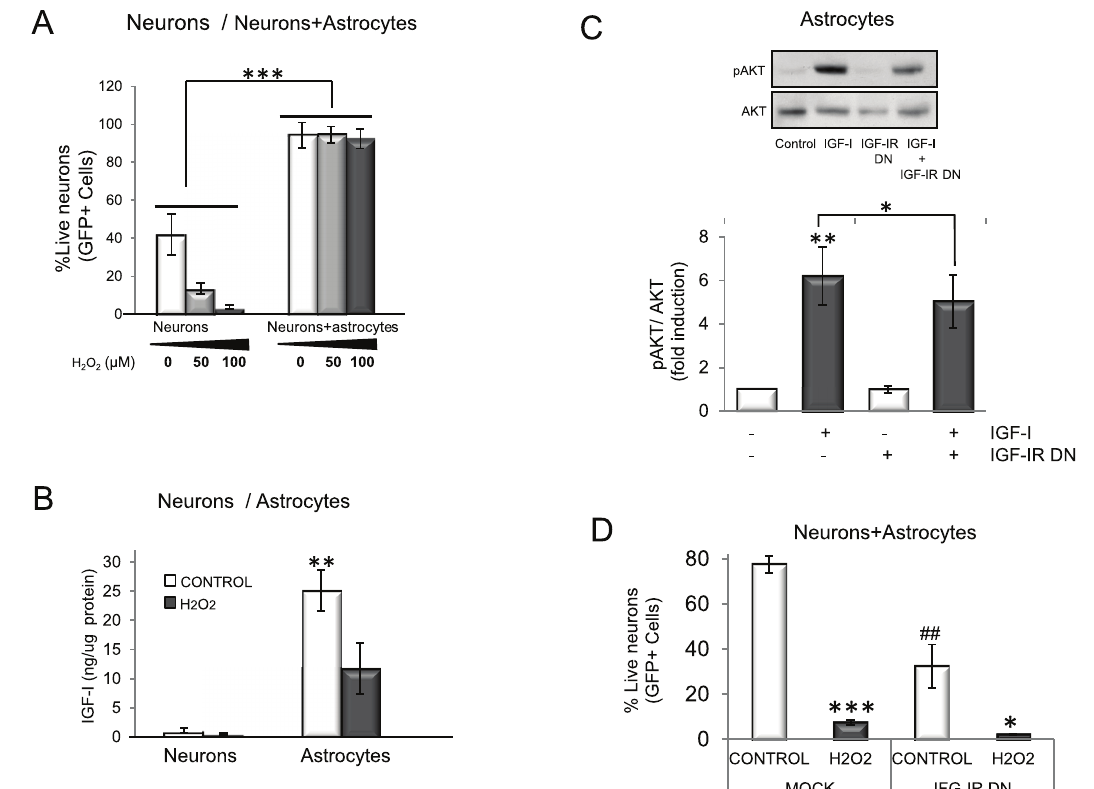
Figure 1. IGF-I signalling participates in astrocyte neuroprotection against oxidative injury. A ) Neurons are protected from oxidative stress in the presence of astrocytes whereas when cultured alone they rapidly die. Viability of GFP neurons was measured as the number of green (GFP + ) cells two days after H O treatment in the presence or absence of wild type astrocytes (F=41.85; ***p<0.001 vs. neurons alone. 2 2 B ) Both astrocytes and neurons secrete IGF-I, although astrocytes produce much higher levels (*p<0.05 vs neurons). H O lowers IGF-I 2 2 secretion. C ) In the presence of a dominant negative IGF-IR (IGF-IR DN) signalling by IGF-I was markedly reduced. Astrocytes were transfected with IGF-IR DN or mock transfected, and the ratio pAkt/Akt (histograms) was measured as an index of IGF-I signalling. Representative blots and quantitative histograms are shown (2 way ANOVA, IGF-I and IGF-IR DN interaction: p<0.05, F=6.99; IGF-I p<0.01, F=13.46; IGF-IR DN p<0.05, F=7.06; Post-hoc: **p<0.01 vs control (mock-transfected) and *p<0.05 vs. IGF-I+IGF-IR DN). D ) Blockade of IGF-IR function with IGF-IR DN compromises neuroprotection by astrocytes. GFP neurons were seeded on top of wild type astrocytes transfected with an IGF-IR DN construct or mock-transfected (control) and exposed to 100 µM H O . Viability of GFP neurons was measured after 5 days (2 way ANOVA, 2 2 H O and IGF-IR interaction: p<0.05, F=10.77; H O p<0.01, F=68.92; IGF-IR DN p<0.05 F=17.86; post-hoc: ***p<0.001, *p<0.05 vs. Control; 2 2 2 2 ##p<0.01 vs mock). Experiments were done at least 3 times in this and following figures. Bars are SEM in all